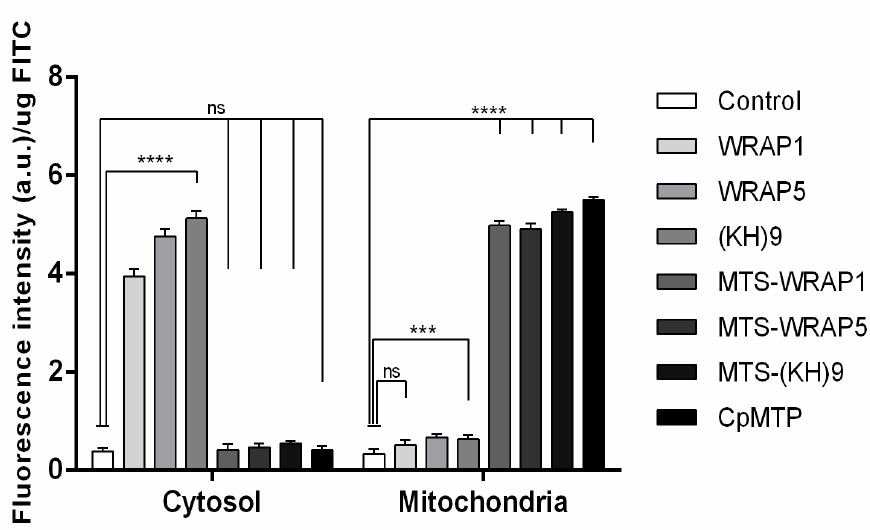
Figure 5. FITC fluorescence intensity (arbitrary units, a.u.) in the cytosol and mitochondria of fibroblast cells after 12h transfection mediated by WRAP1/pND1, WRAP5/pND1, (KH)9/pND1, MTS-WRAP1/pND1, MTS-WRAP5/pND1, MTS-(KH)9/pND1 and CpMTP/pND1 systems conceived at N/P ratio of 5. Untreated cells were used as control. The data were obtained by calculating the average of four independent experiments and are presented as mean ± SD; not significant (n.s.), *** p < 0.001 and **** p < 0.0001.